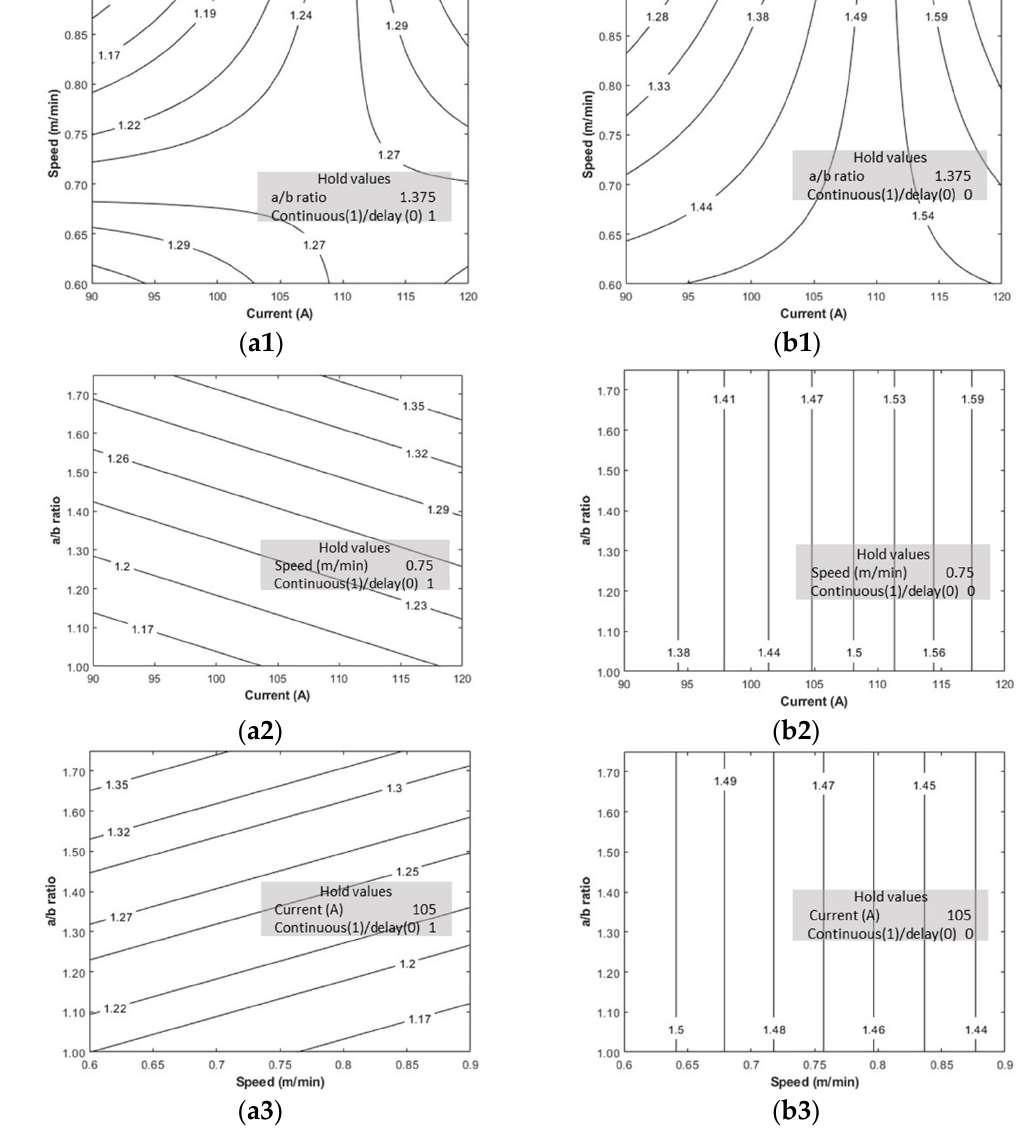
Figure 8. Contour plots for distortion ( a1 – a3 ) Continuous and ( b1 – b3 ) delayed deposition. Torch speed vs. current plot, fi xed geometry (Figure 8(a1,b1)): From this plot, it can